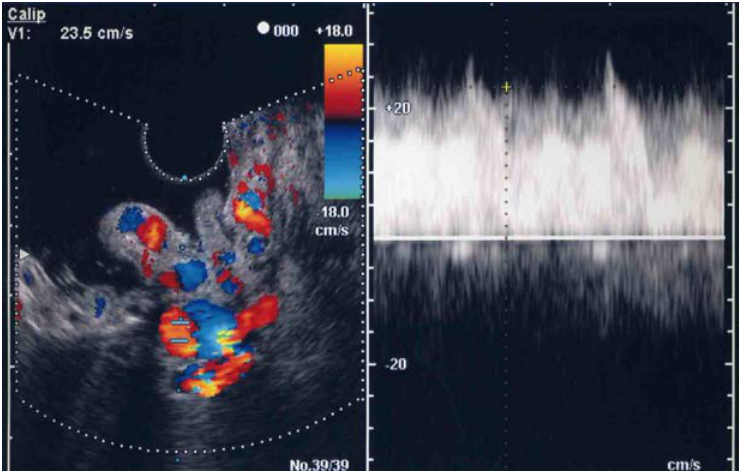
Figure 3. Endoscopic color Doppler ultrasonography showing a color flow image of gastric varices due to splenic vein occlusion that flow as a continuous wave.